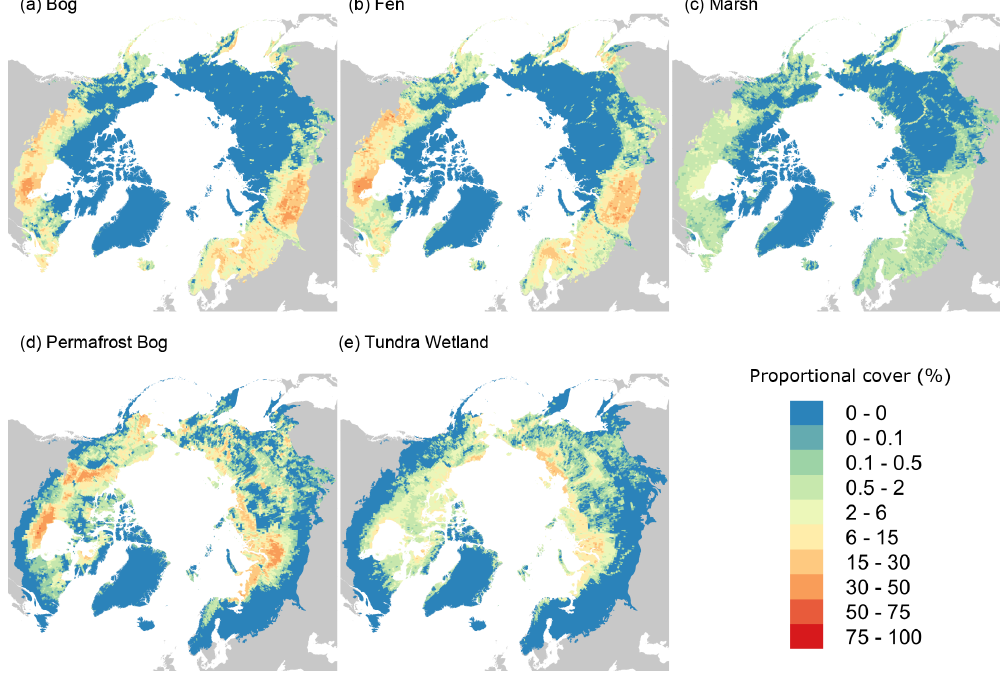
Figure 2. Predicted distribution of wetland classes across the BAWLD domain: (a) Bog, (b) Fen, (c) Marsh, (d) Permafrost Bog, and (e) Tundra Wetland.